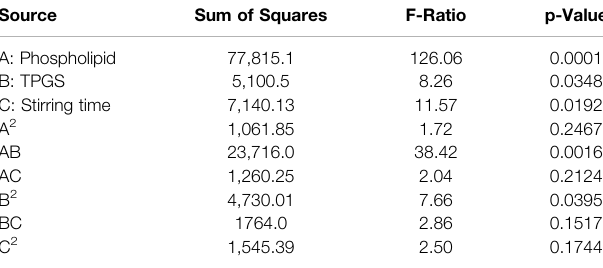
TABLE 2 | Analysis of variance data for particle